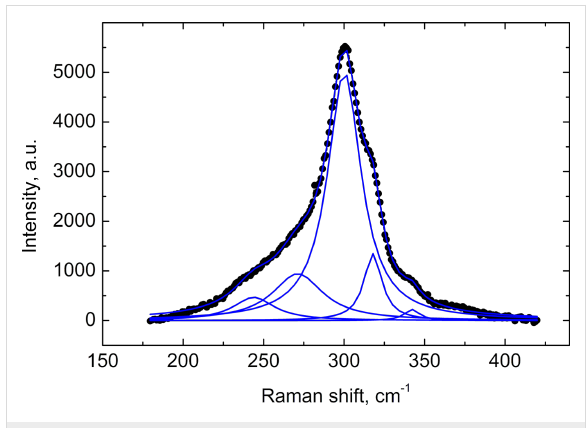
Figure 5: Raman spectrum of the In 2 O 3 (400)/CdS system prepared by using 40 SILAR cycles of CdS deposition after background subtraction (circles) and its fitting by the superposition of five Lorentz lines.